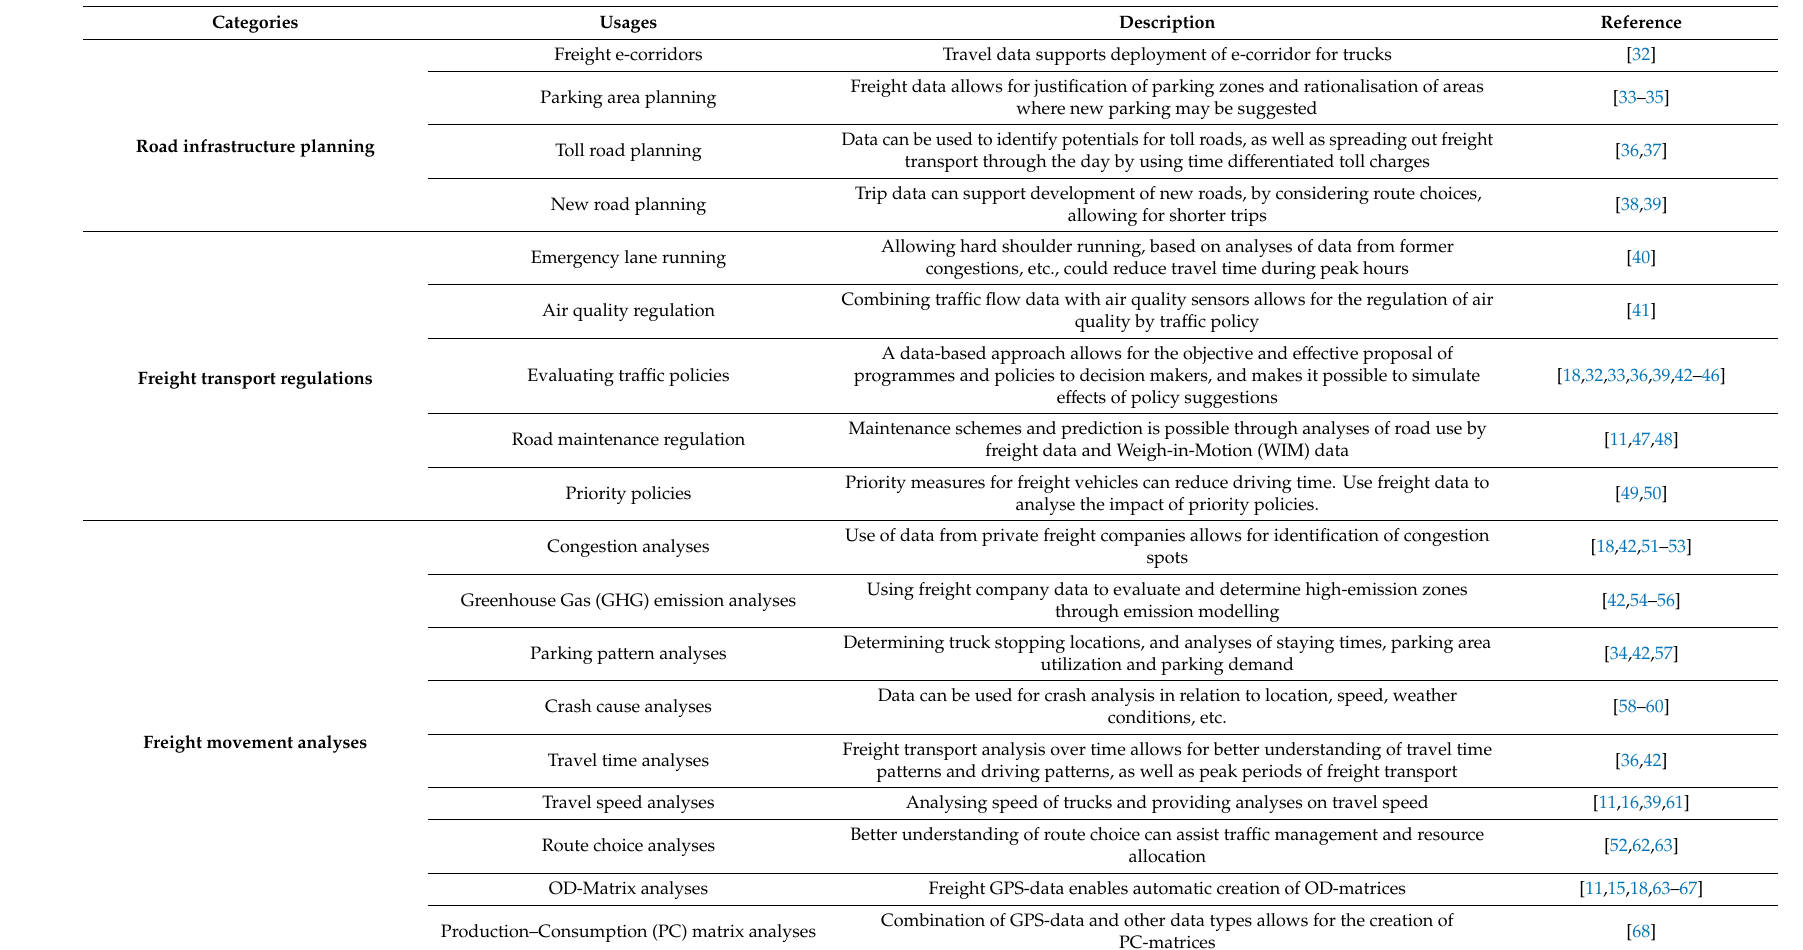
Table 1. Categories and data usages identified from the literature